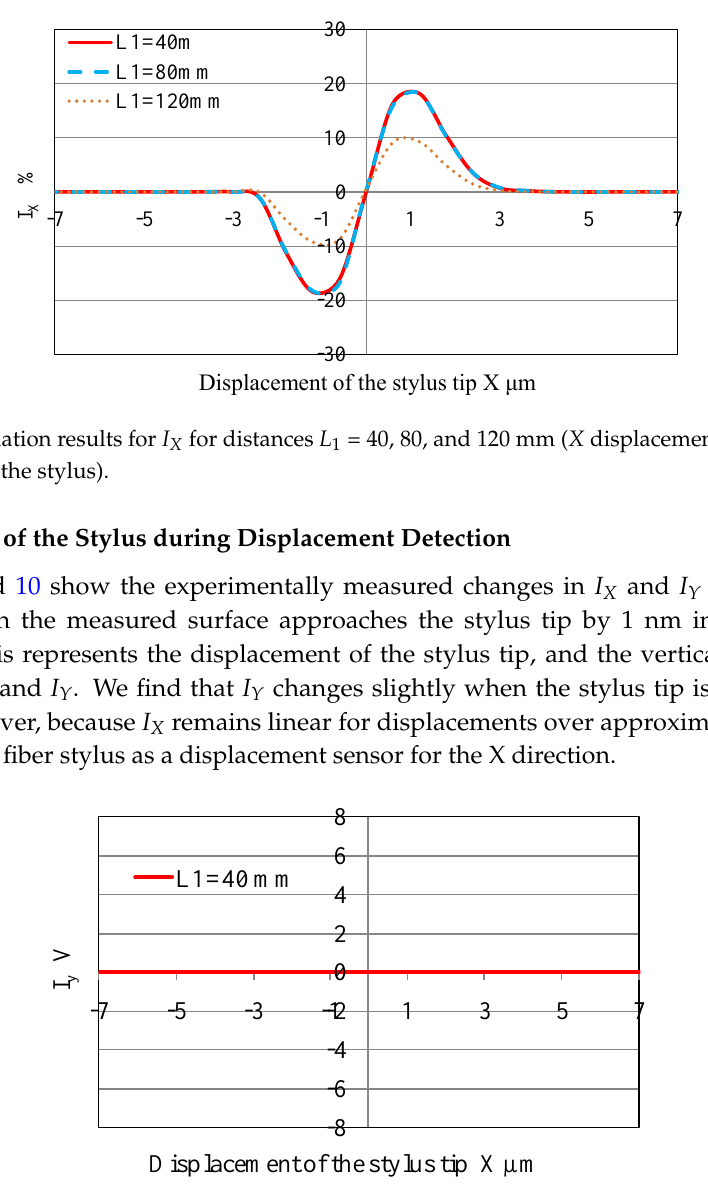
Figure 7. Simulation results for I Y for distances L 1 = 40, 80, and 120 mm ( X displacement of the stylus tip = ±7 µm).